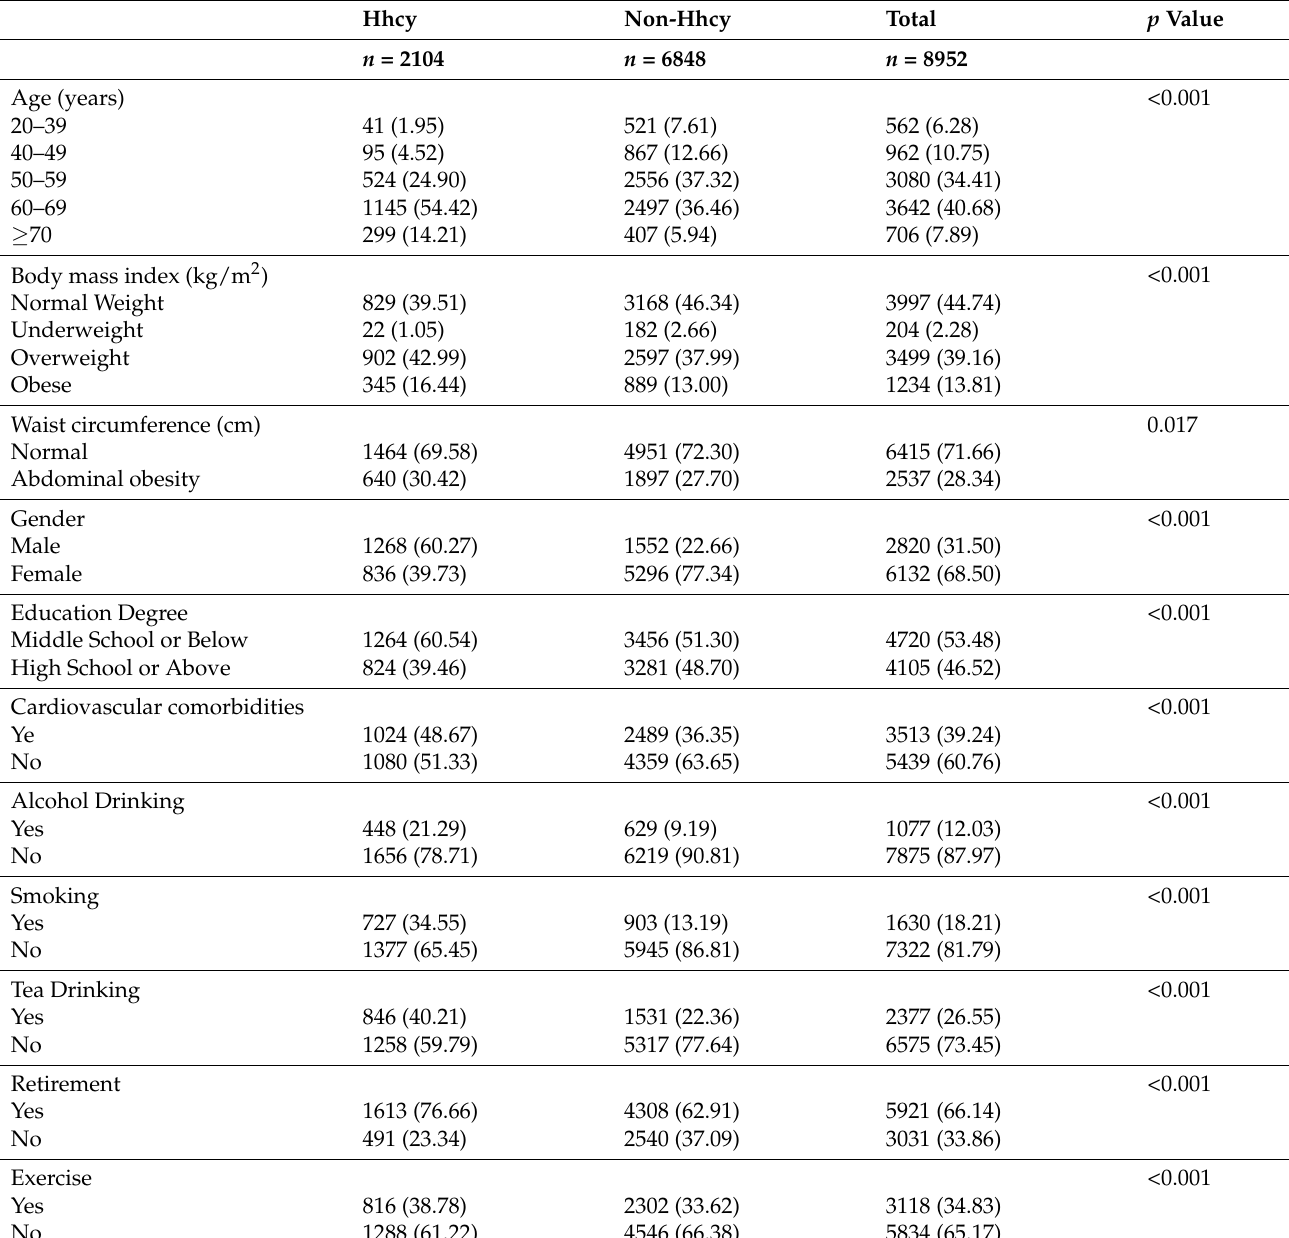
Table 1. Distributions of study variables among subjects with or without hyperhomocysteinemia